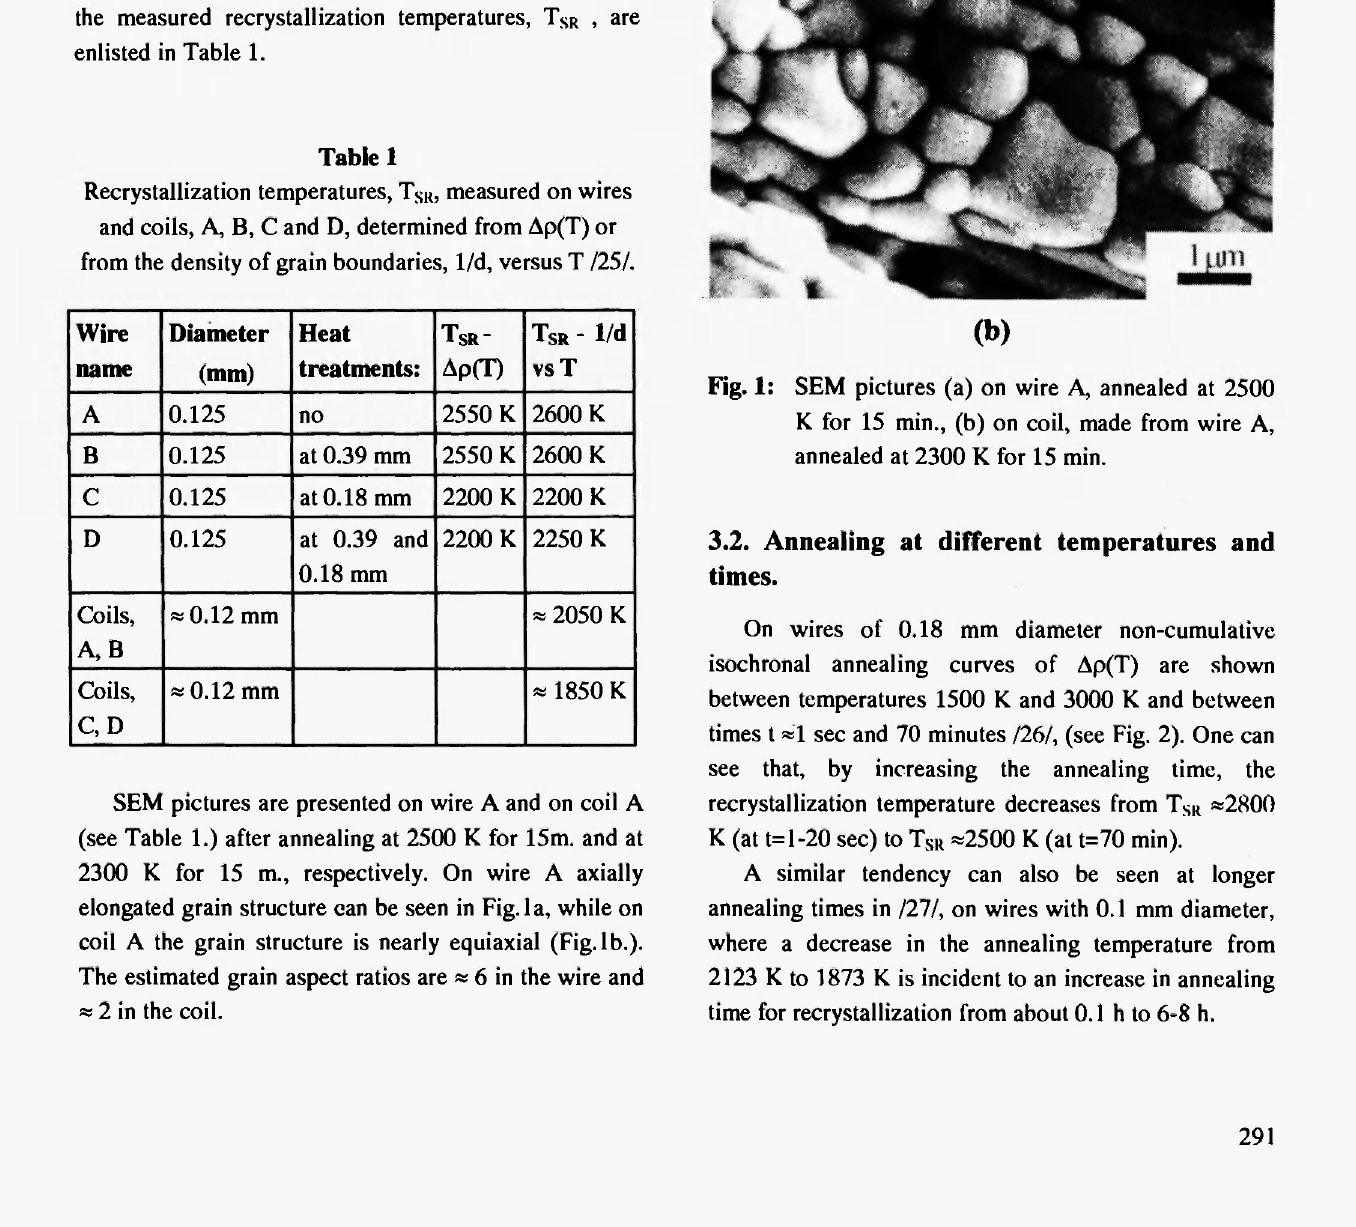
Fig. 1: SEM pictures (a) on wire A annealed at 2500 Κ for 15 min., (b) on coil, made from wire A, annealed at 2300 Κ for 15